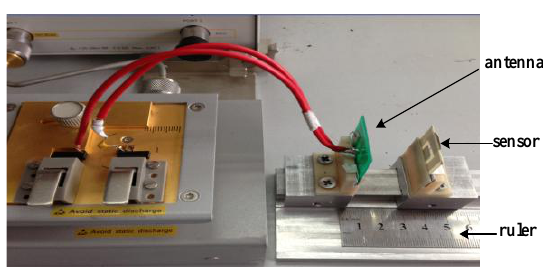
Figure 10. Coupling distance testing platform.